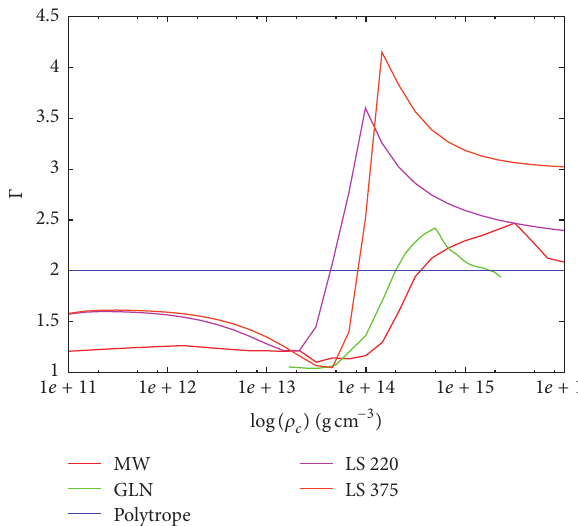
Figure 9: EoS index Γ versus central density for various equations of state. Large Γ implies a stiff EoS.